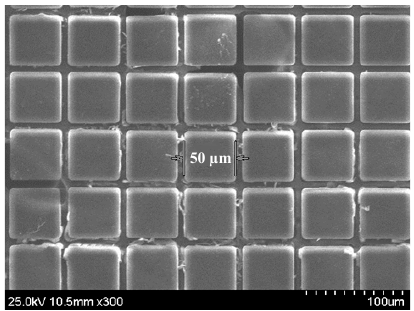
Figure 1. SEM image of 50- μ m sized cubic microstructures made of biodegradable poly-capro-lactone (PCL)